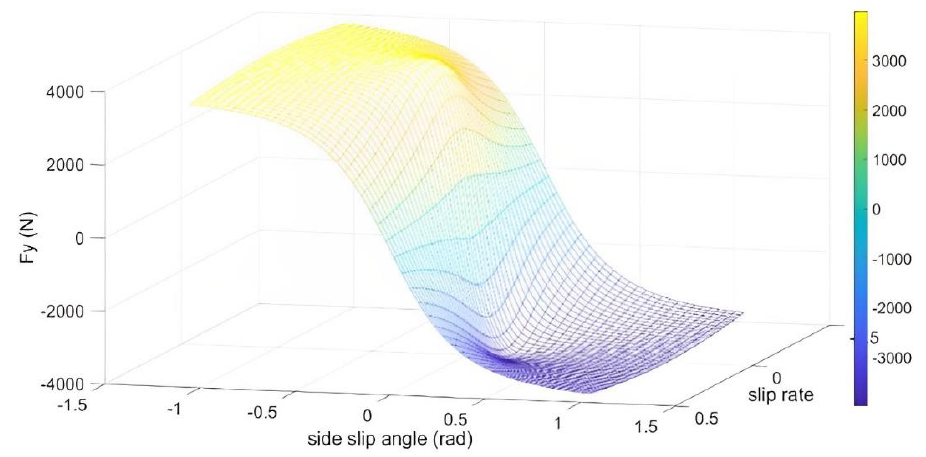
Figure 5. Lateral forces calculated by the Brush model.